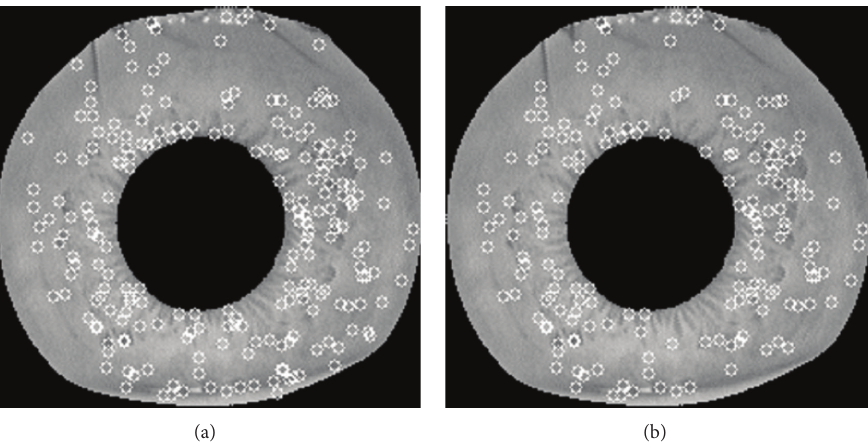
Figure 3: The stages of keypoints selection on annular iris image using SIFT. (a) shows the 267 keypoints at all detected maxima and minima of DOG function, and (b) shows the final 216 keypoints remaining after applying a threshold on minimum contrast (0.01) and a value of ratio of principal curvatures greater than 5.